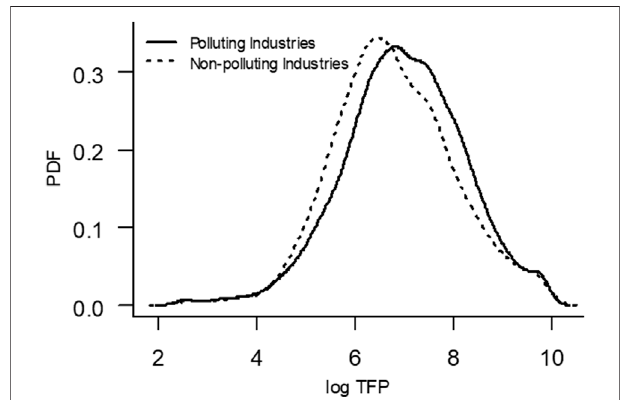
FIGURE 6 | Log TFP distributions in the western region.